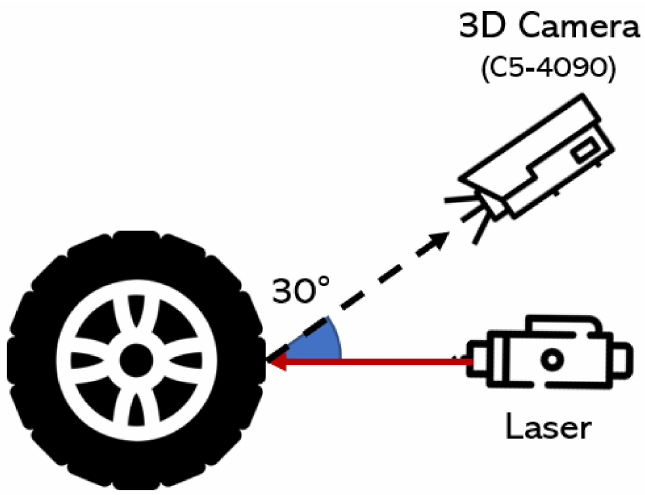
Figure 5. Tire depth image capture using a laser and 3D